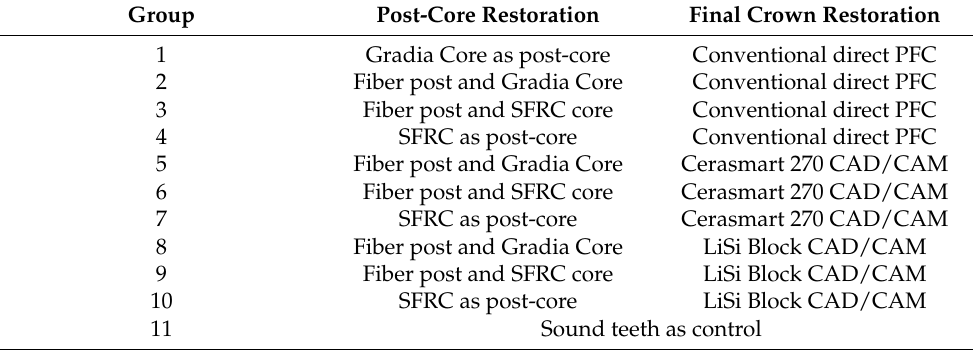
Figure 2. Diagram showing the restorative approaches with various post-core restorations. Approach ( A ): Gradia Core as post-core and complete crown of PFC. Approach ( B ): fiber post and Gradia Core to build up core and complete crown of either PFC or CAD/CAM. Approach ( C ): fiber post and core made of SFRC and complete crown of either PFC or CAD/CAM. Approach ( D ): SFRC as post-core and complete crown of either PFC or CAD/CAM. Table 2. Different post-core and crown restorations ( n = 10/group).